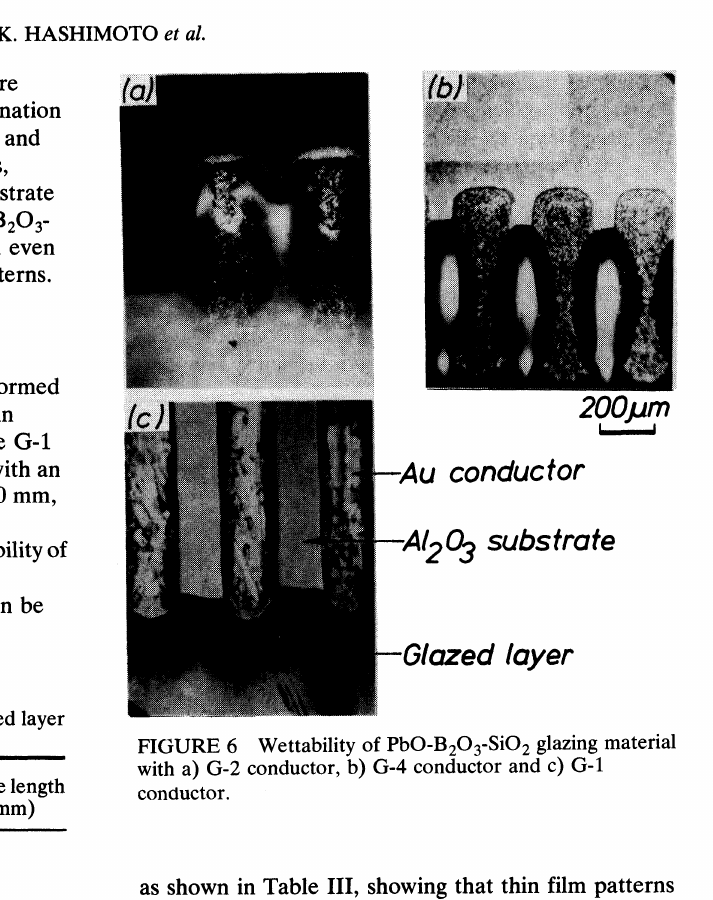
FIGURE 6 Wettability of PbO-B203-SiO 2 glazing material with a) G-2 conductor, b) G-4 conductor and c) G-1